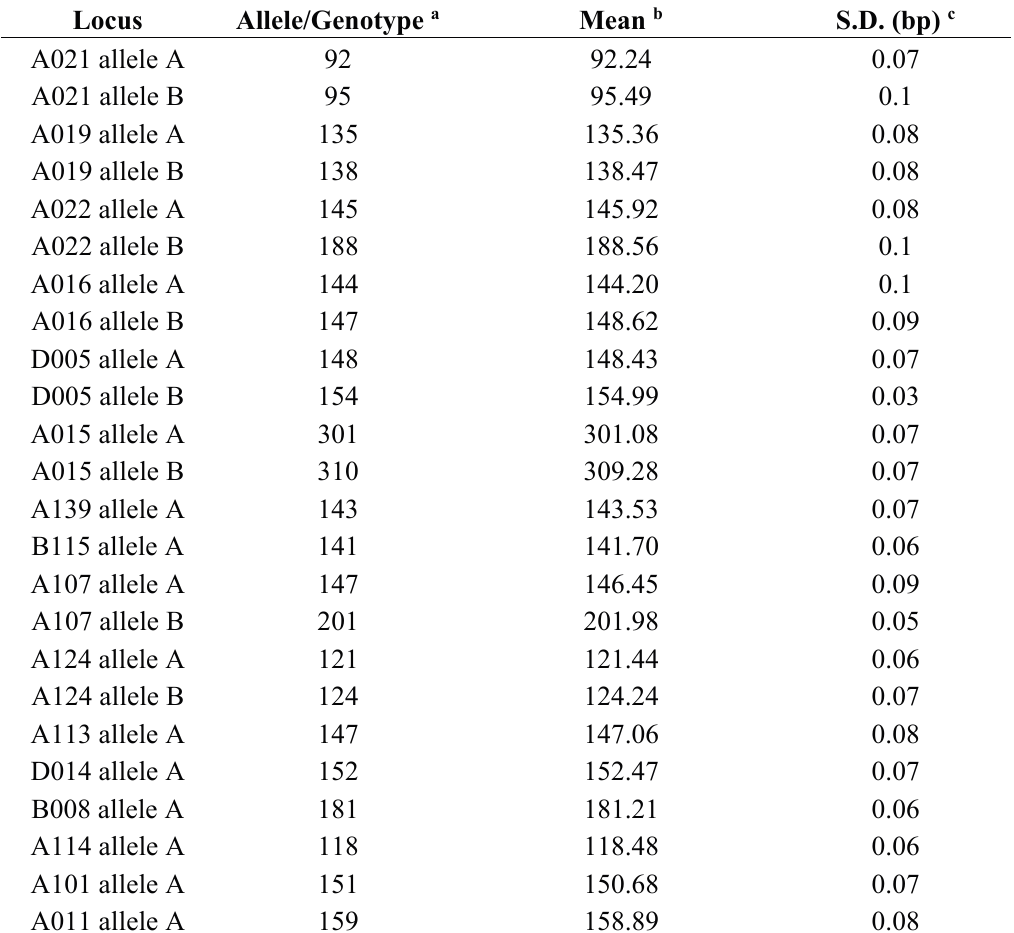
Table 2. Measurements of precision for 21 STRs from E. autumnata